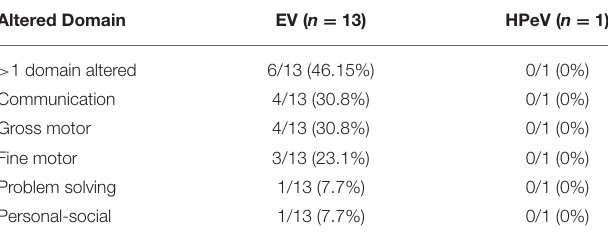
TABLE 4 | Second assessment of neurodevelopment in medium-term with the ASQ-3